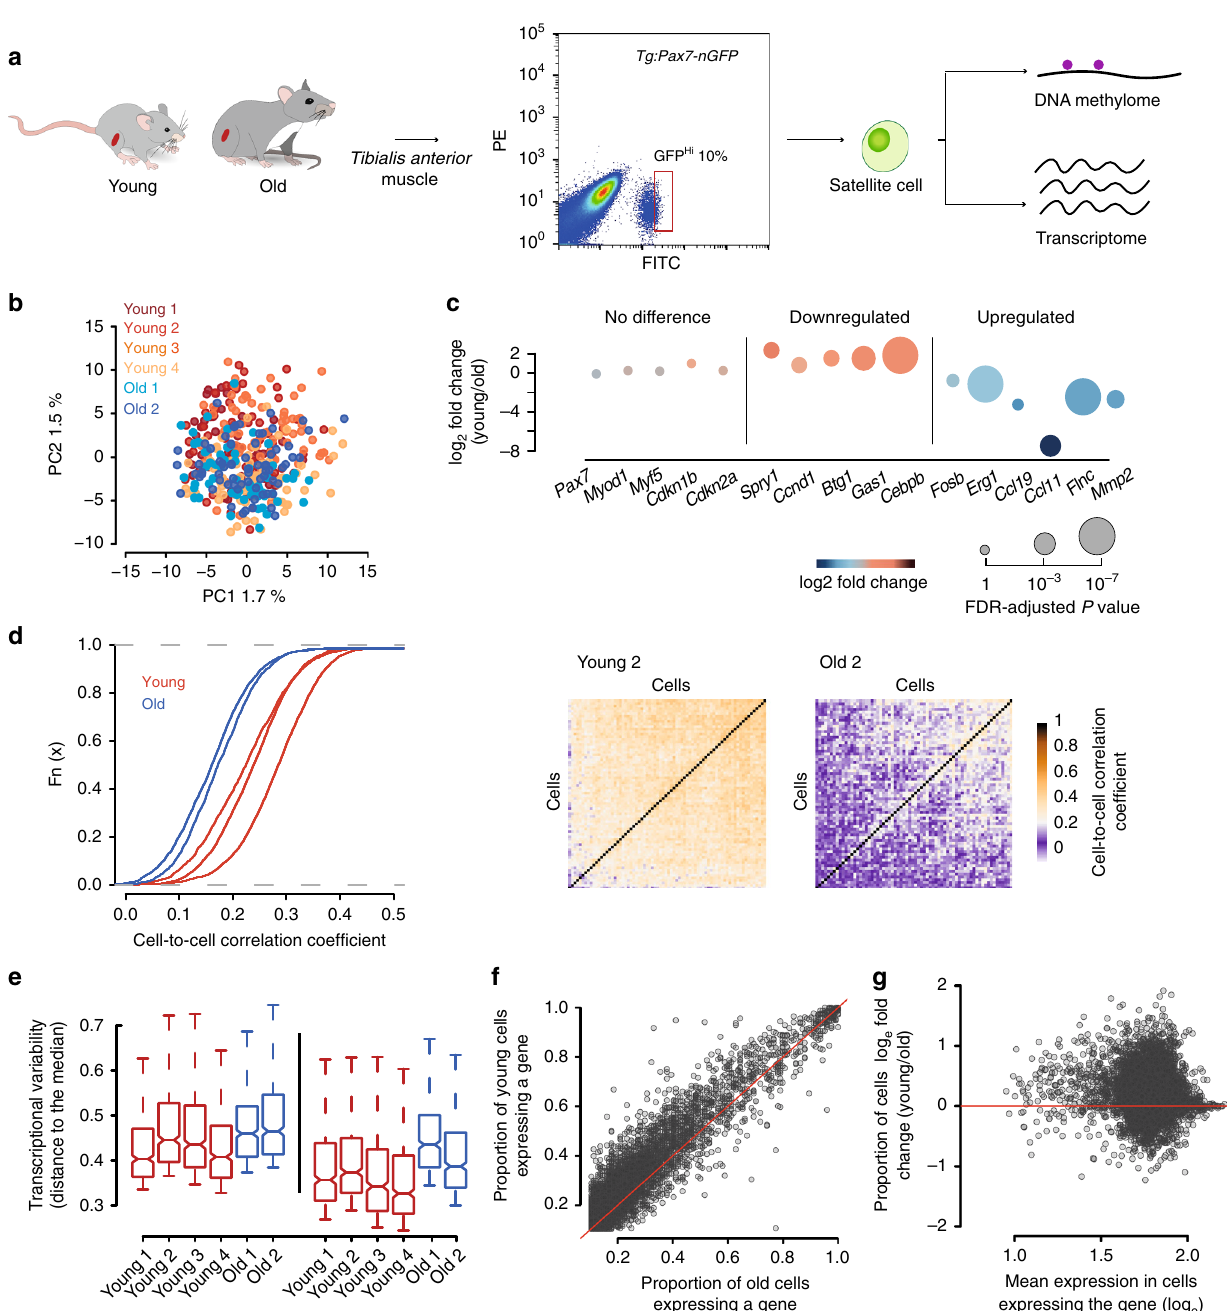
Fig. 1 Aged muscle stem cells have increased cell-to-cell transcriptional variability. a Experimental scheme. Single cells were isolated from Tg:Pax7-nGFP young and old mice and subjected to parallel single-cell methylation and RNA sequencing. b Principal Component Analysis (PCA) of a total of 377 cells from young ( n = 4) and old ( n = 2) individuals. c Selected markers and differentially expressed genes between young and old cells. Source data are provided in Supplementary Data 1. d Cumulative distribution of cell-to-cell Spearman correlation values per individual (left) showing that transcriptional heterogeneity dramatically increases with age. Heatmap showing cell-to-cell Spearman correlation values from a young and an old mouse (right). e Distance to the median of the top 500 most variable genes among all genes (left) and of the top 500 most variable genes among the 5127 common genes expressed in the six individuals (right). For all boxplots, the box represents the interquartile range and the horizontal line in the box represents the median ( n = 500). f Frequency of gene expression in young and old cells. Note that the proportion of cells expressing a given gene is reduced in old cells. g Independence between frequency of gene expression differences and gene expression level observed similar results regarding transcriptional variability following immunostaining (Supplementary Fig. 8). Young and (Supplementary Fig. 7). Furthermore, we measured the levels of old muscle stem cells showed homogeneous nGFP expression, Cdh15 and Itgb1 proteins in quiescent muscle stem cells from consistent with the absence of difference in Pax7 expression level young and old Tg:Pax7-nGFP mice after isolation of single between ages as measured by scM&T-seq (Fig. 1c). However, myo fi bres and quanti fi cation of immuno fl uorescence intensity while all the cells analysed expressed Cdh15 and Itgb1 protein in NATURE COMMUNICATIONS| (2019) 10:4361